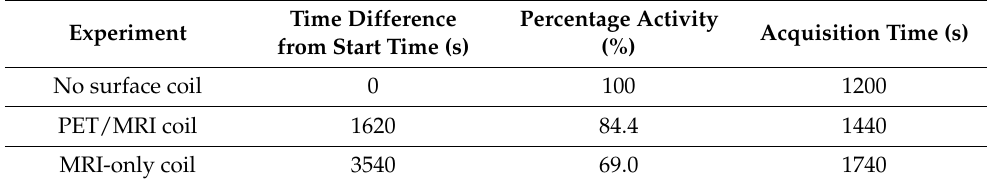
Table 1. Acquisition times for each of the configurations to correct for radioactive decay between the different phantom experiments.